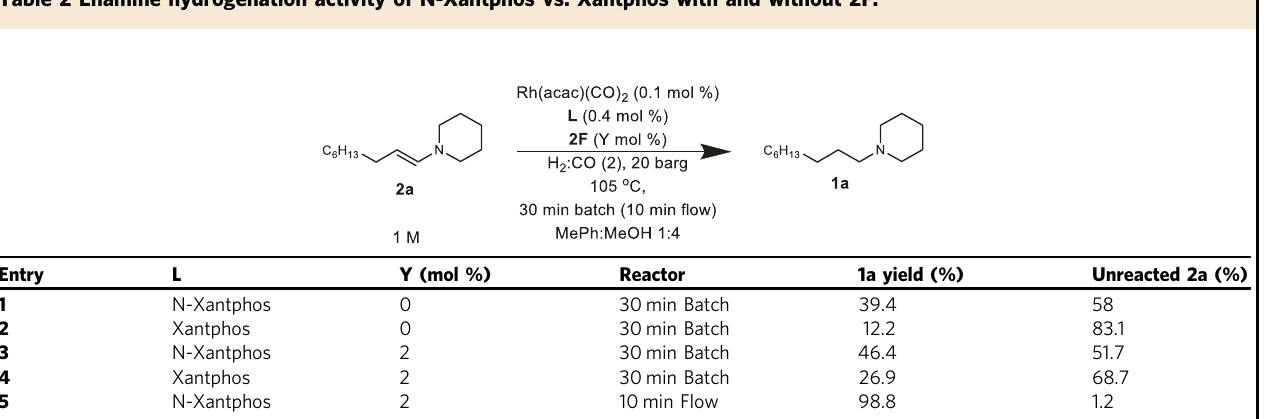
Table 2 Enamine hydrogenation activity of N-Xantphos vs. Xantphos with and without